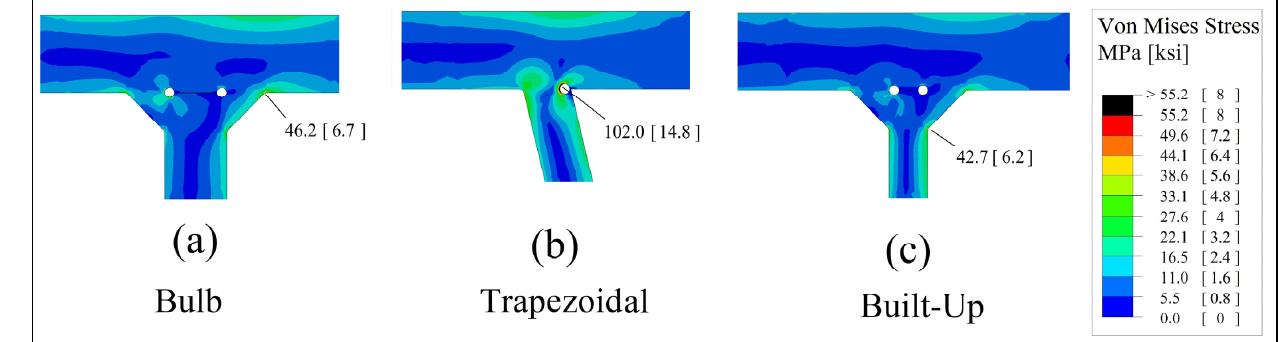
Figure 18. Von Mises stress distribution under the steering wheel load in continuum case 1.